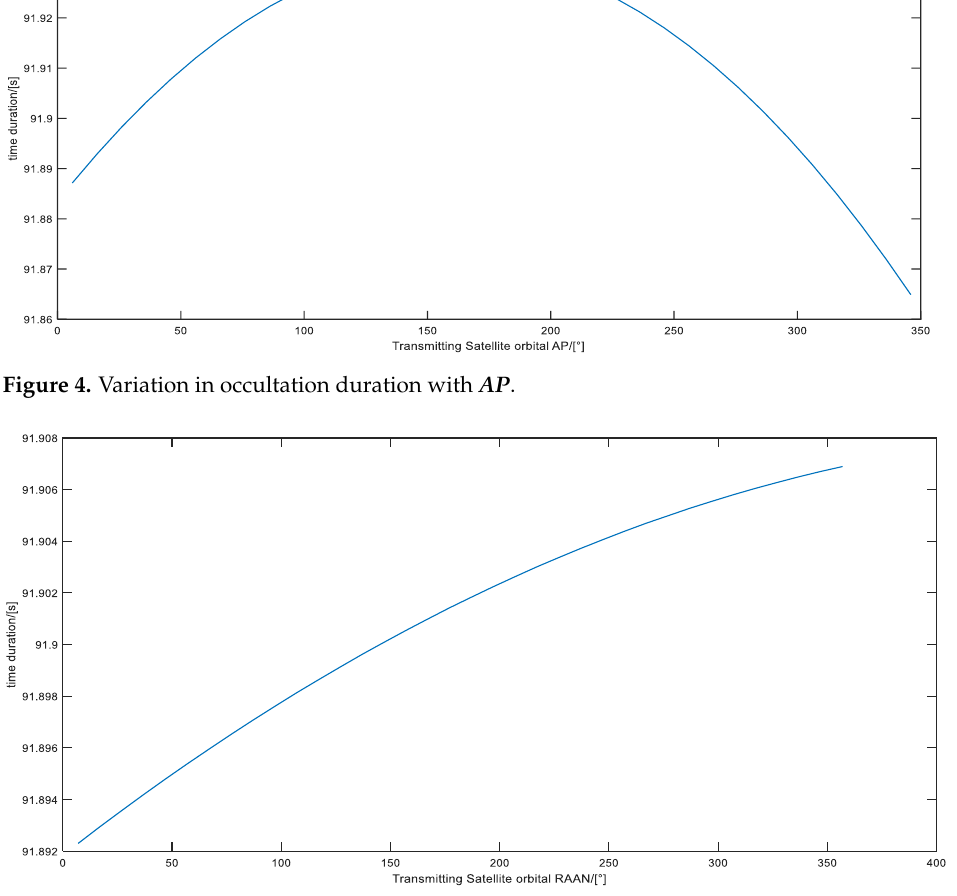
Figure 5. Variation in occultation duration with RAAN .